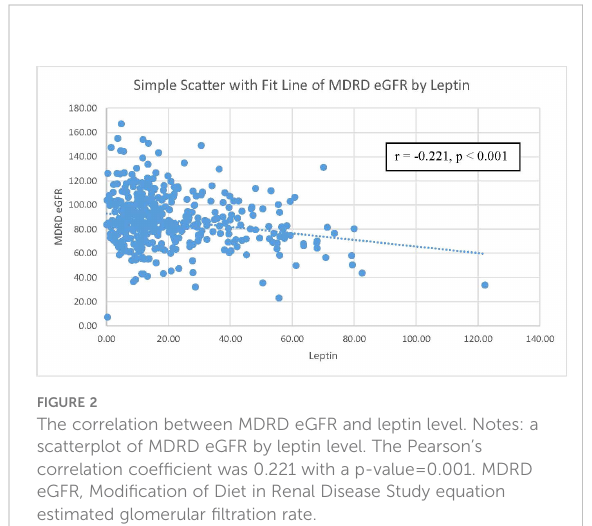
FIGURE 2 The correlation between MDRD eGFR and leptin level. Notes: a scatterplot of MDRD eGFR by leptin level. The Pearson ’ s correlation coef fi cient was 0.221 with a p-value=0.001. MDRD eGFR, Modi fi cation of Diet in Renal Disease Study equation estimated glomerular fi ltration rate.